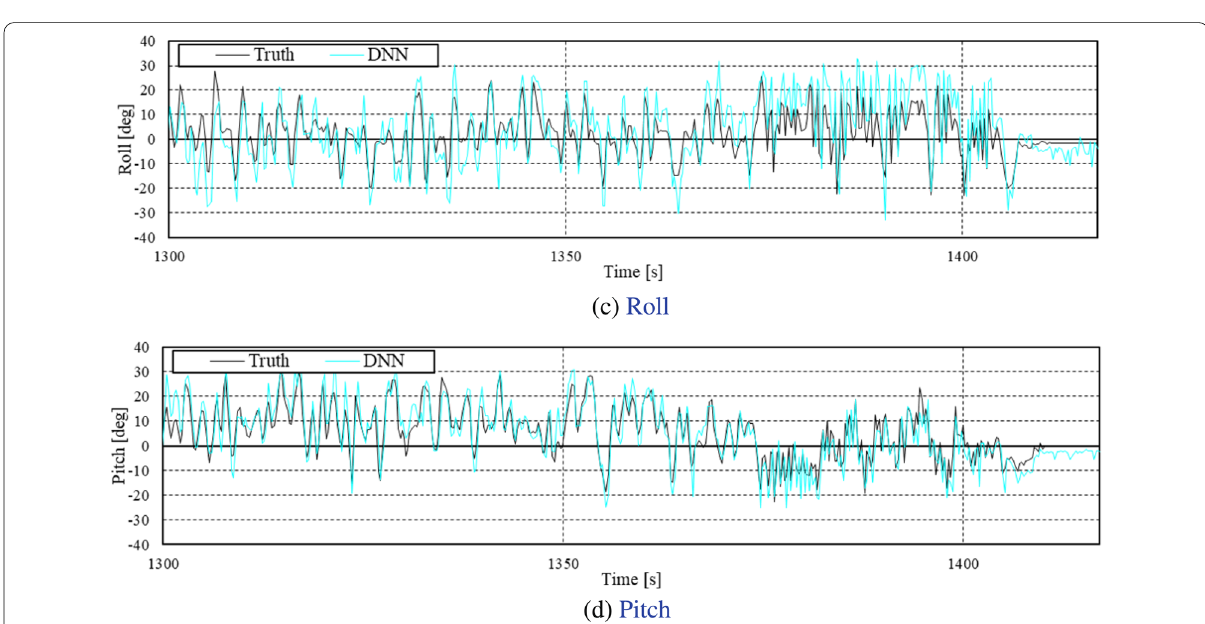
Fig. 13 Real-time plotting in indoor experiment. The DNN had larger error when the sensors moved intensely